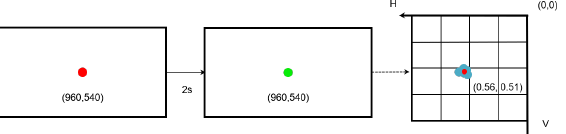
Figure 4. Illustration of the one-point calibration process for one participant.